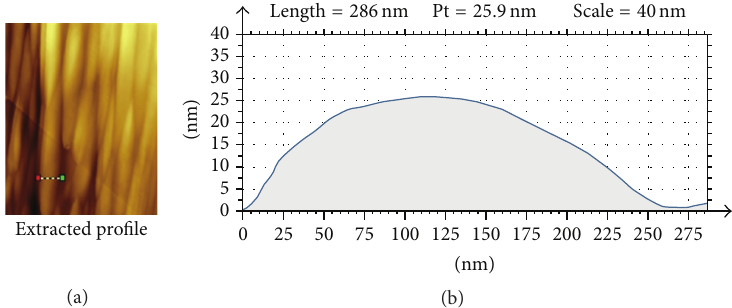
Figure 2: (a) NCAFM image of Dye 1 J-aggregates adsorbed on the TiO 2 anode. (b) The topographic profile along the line indicated in the topography image in (a).